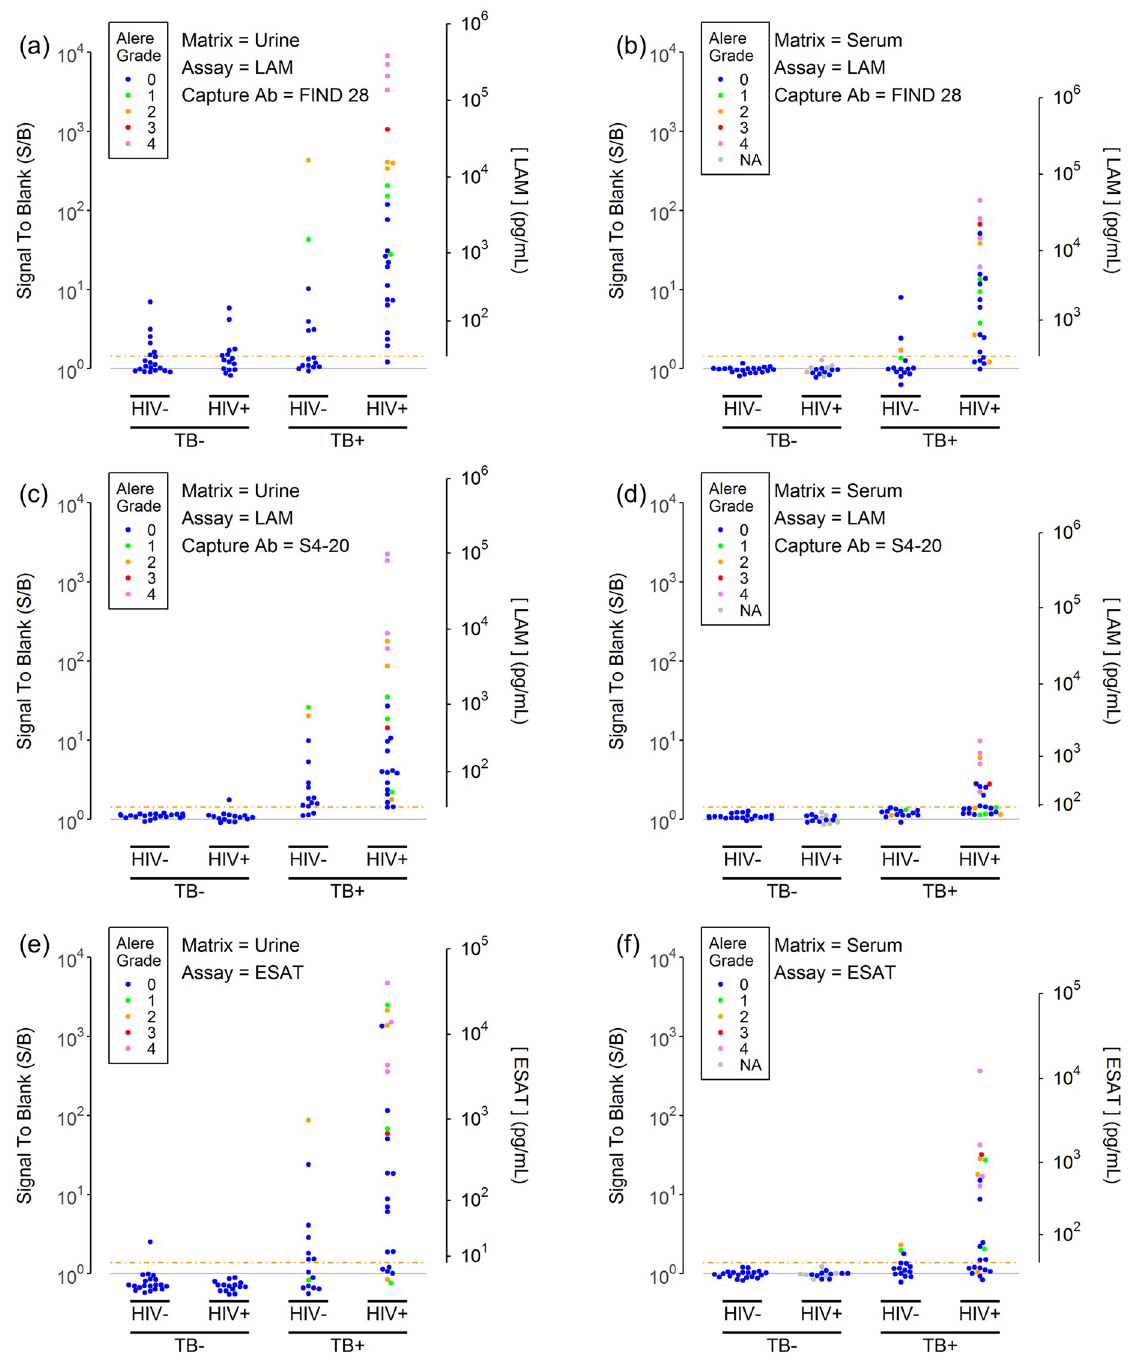
Fig 2. LAM and ESAT-6 concentrations in urine (left column) and serum samples (right column). The plots show LAM (panels a-d) and ESAT-6 (panels e-f) assay signals (normalized to the blank signal) for a set of urine (panels a, c and e) and serum samples (panels b, d and f) as a function of the TB and HIV status of the donor. LAM assay results are provided for the two most sensitive anti-LAM capture antibodies: FIND 28 (panels a-b) and S4-20 (panels c-d). The gray horizontal shows the blank signal (S/B = 1). The dashed orange line shows the assay threshold (S/B = 1.375 for the LAM assays, S/B = 1.425 for the ESAT-6 assay) which is equal to the limit of detection (LOD). The second y axis provides estimated analyte concentrations for concentrations above the LOD. The points are colored by the Alere LF-LAM results for urine from the same subjects (0 = LF-LAM negative, 1 to 4 represents increasing LF-LAM test color intensity as determined by comparison to the Alere LF-LAM reference card).